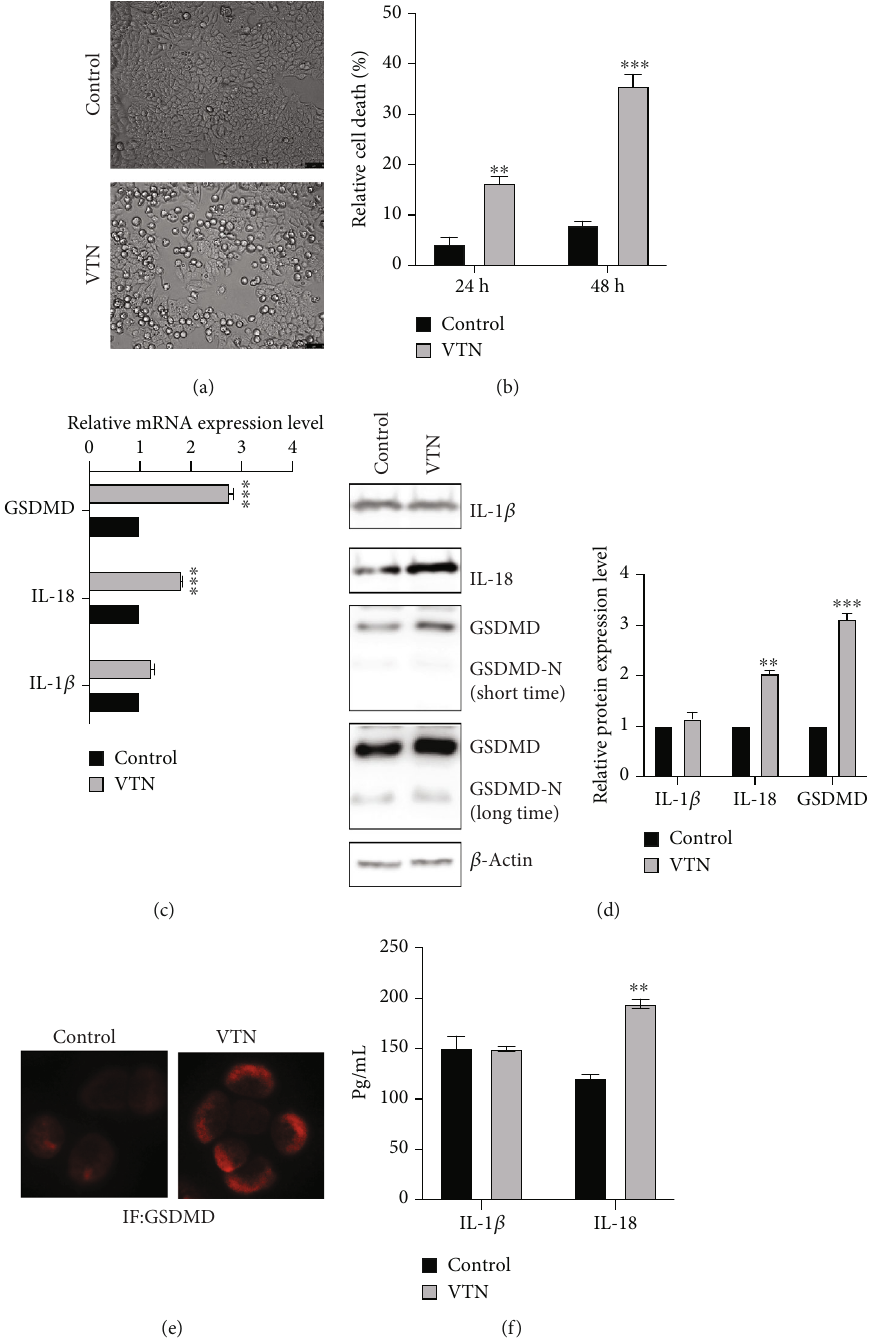
Figure 7: VTN triggered cell pyroptosis. (a) LDH assay was performed to determine relative cell death in the indicated group in THP-1- derived macrophages; data represented the mean ± SD of three independent experiments; t -tests were used to analyze statistical signi fi cance; ∗∗∗ p < 0 : 001 , ∗∗ p < 0 : 01 . (b) Real-time PCR was performed to examine the mRNA level of GSDMD, IL-1b, and IL-18 expression in THP-1-derived macrophages. Data represented the mean ± SD of three independent experiments; t -tests were used to analyze statistical signi fi cance; ∗∗∗ p < 0 : 001 . (c) Western blotting was performed to test pyroptosis-related proteins, including GSDMD, IL-1b, and IL-18, in THP-1-derived macrophages with or without VTN (4 μ M) stimulation, and the quanti fi ed results were analyzed by the t -test. Data represented the mean ± SD of three independent experiments; t -tests were used to analyze statistical signi fi cance; ∗∗∗ p < 0 : 001 . (d) The contents of IL-1b and IL-18 in the supernatant and GSDMD/GSDMD-N expression of THP-1-derived macrophages with or without VTN treatment were detected by ELISA; data represented the mean ± SD of three independent experiments; t -tests were used to analyze statistical signi fi cance; ∗∗ p < 0 : 01 . (e) IF assay was performed to detect GSDMD expression in THP-1-derived macrophages with or without VTN